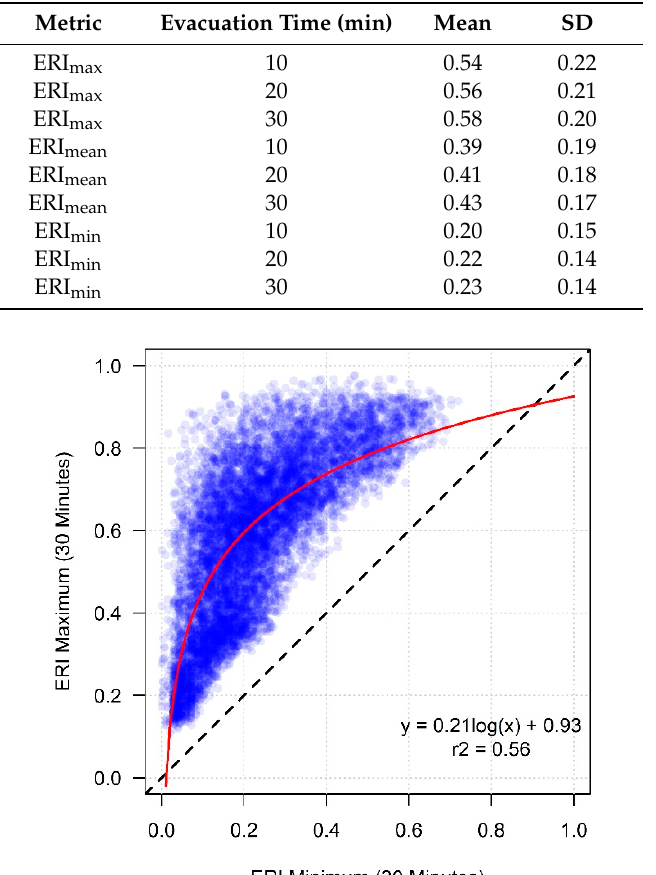
Figure 8. The relationship between ERI max and ERI min for a 30-minute evacuation time frame, where the red line represents a log-linear regression model, and the black dotted line represents a 1:1 relationship between ERI max and ERI min .